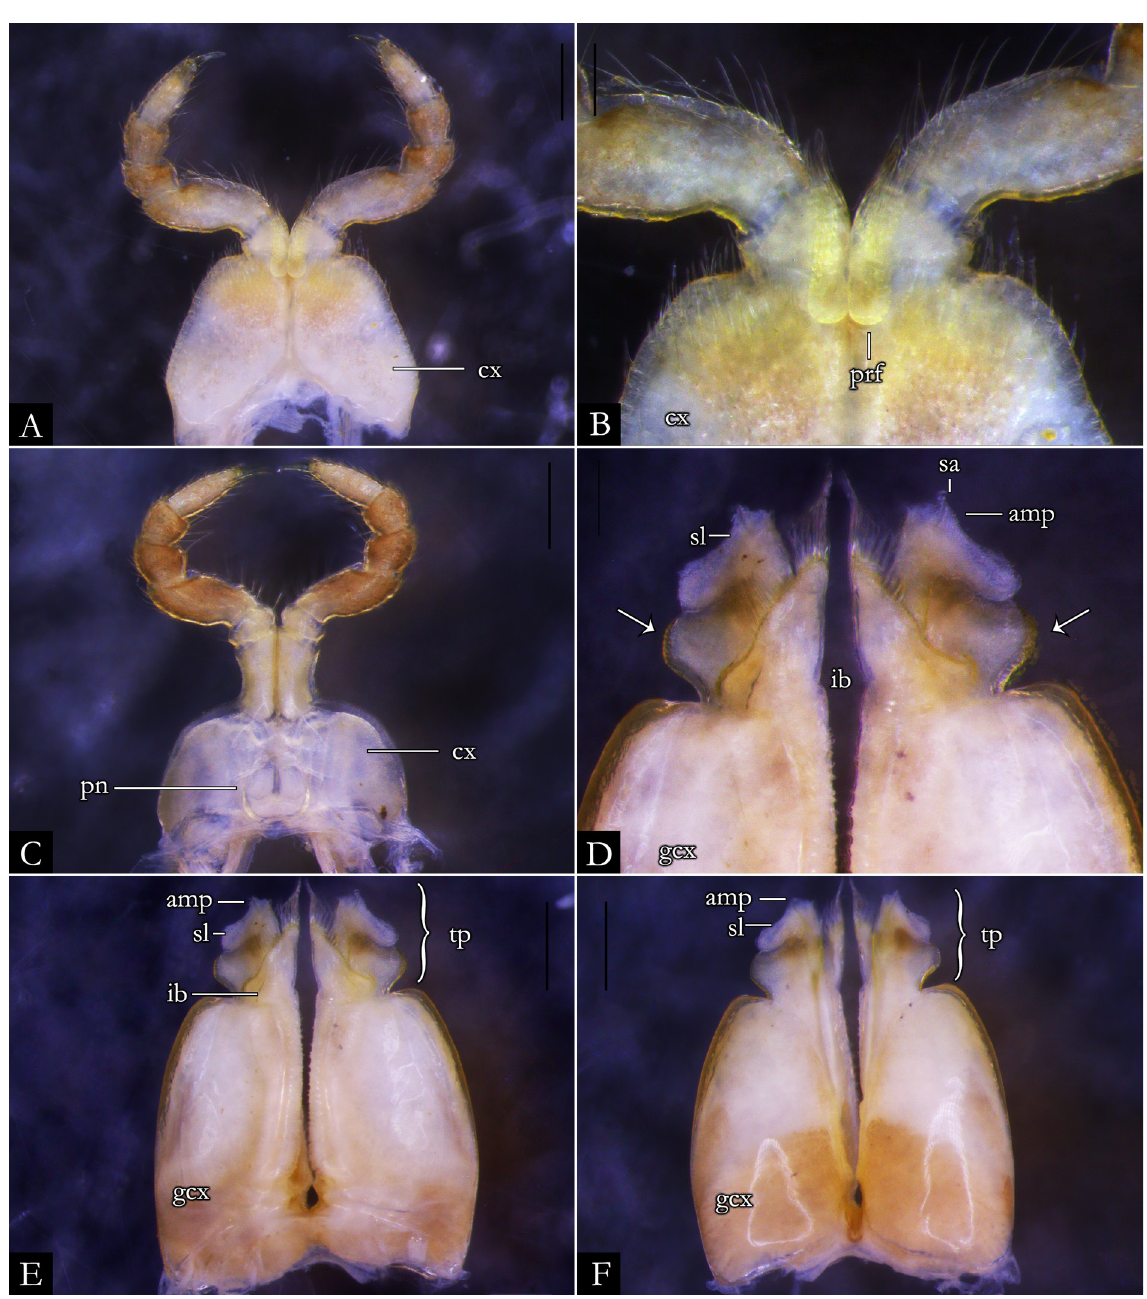
Fig. 146. Pseudonannolene alata sp. nov., holotype, ♂ (IBSP 7874). A . First leg-pair. B . Detail of prefemur. C . Second leg-pair. D . Detail of telopodites, in anal view. E . Gonopods, in anal view. F . Gonopods, in oral view. Abbreviations: see Material and methods. Scale bars: A, C, E–F = 0.5 mm; B, D = 0.2